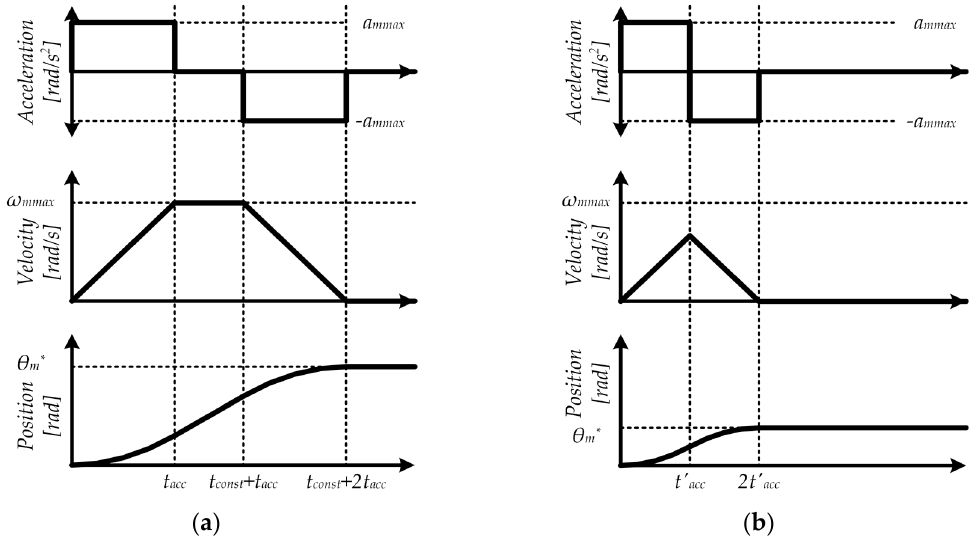
Figure 1. The acceleration, velocity and position profiles: ( a ) the trapezoidal velocity profile; ( b ) the triangular velocity profile.